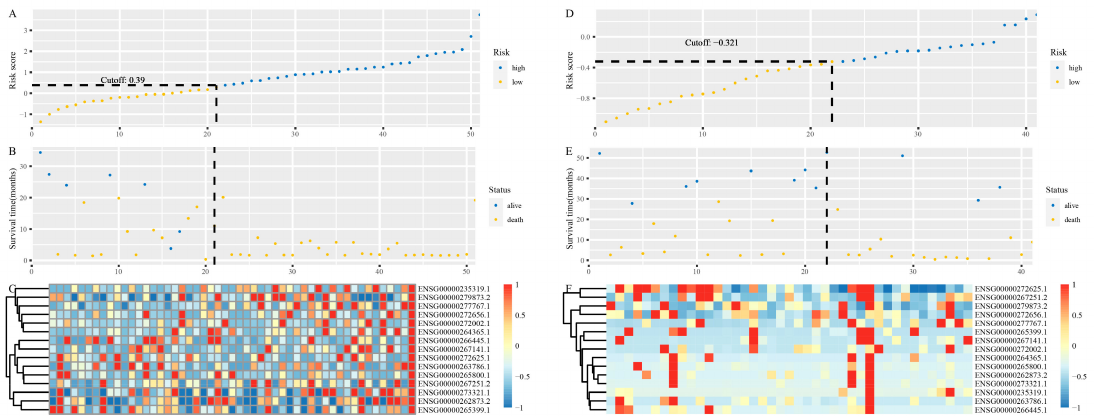
Figure 4. Characteristics of the 15 lncRNAs signature. ( A ) The risk score of each melanoma patient in the training cohort. ( B ) PFS and survival status of patients in the training cohort. ( C ) Heat map of gene expression profiles of melanoma patients in the training cohort. ( D ) The risk score of each melanoma patient in the validation cohort. ( E ) PFS and survival status of patients in the validation cohort. ( F ) Heat map of gene expression profiles of melanoma patients in the validation